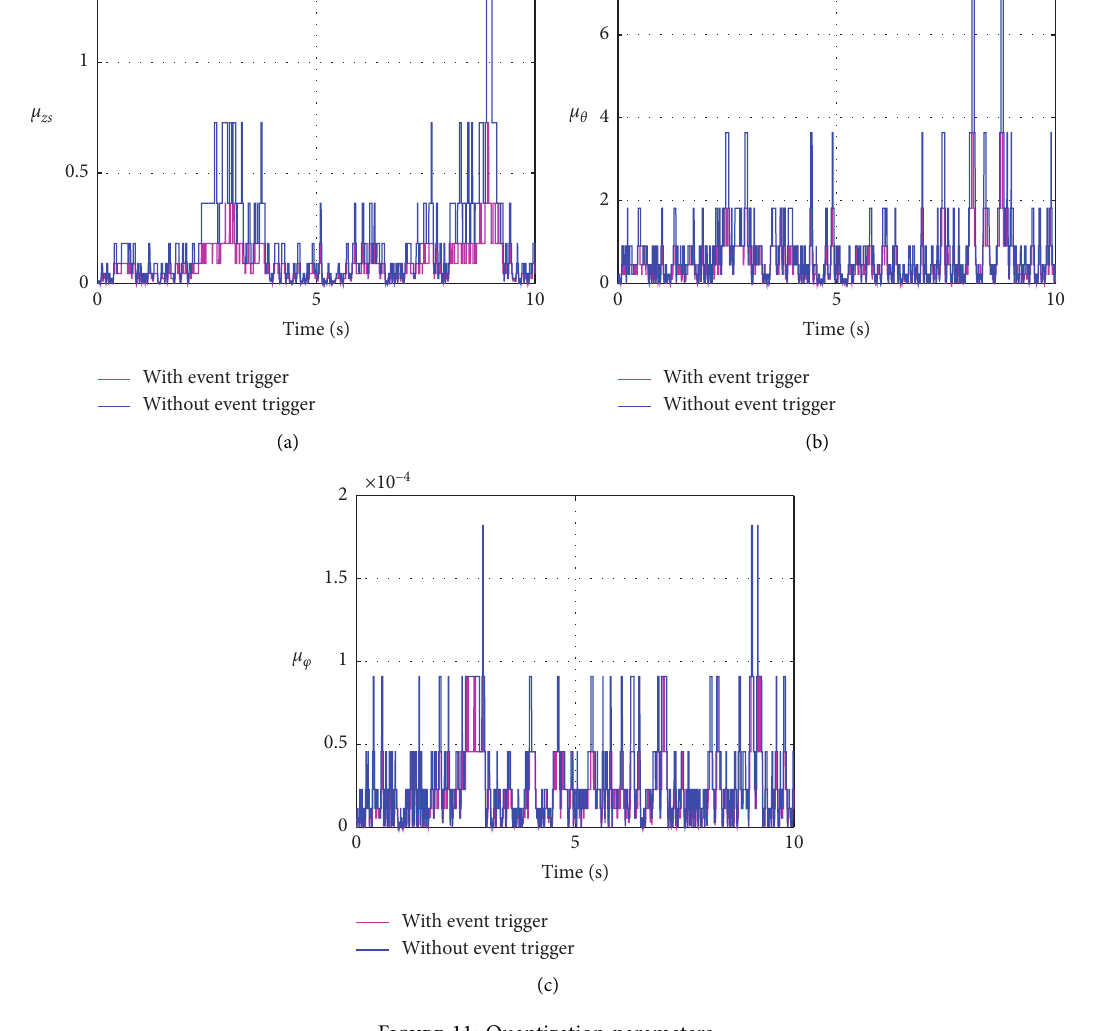
Figure 11: Quantization parameters.